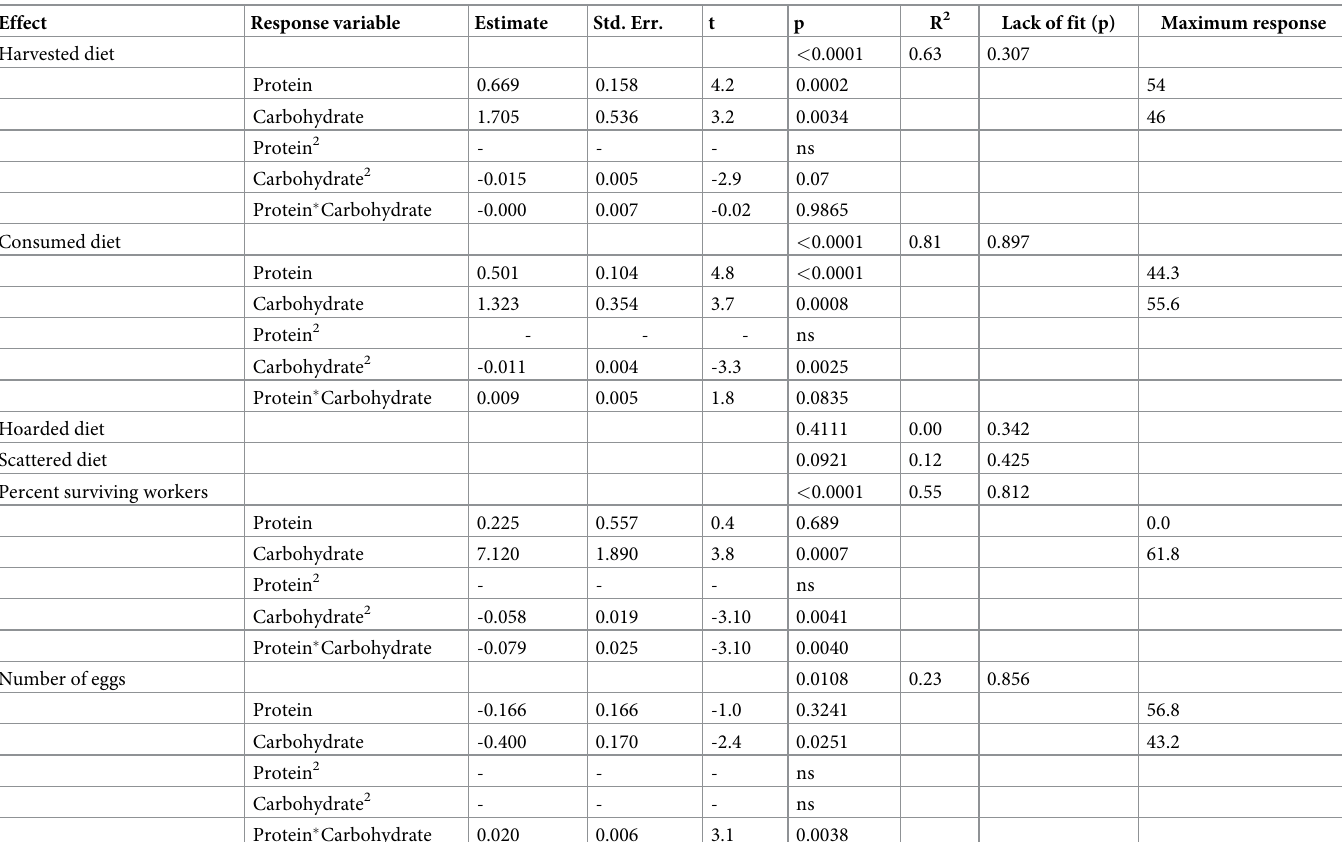
Table 1. Statistical output from Response Surface Models (RSM) analyses of 3-D feeding